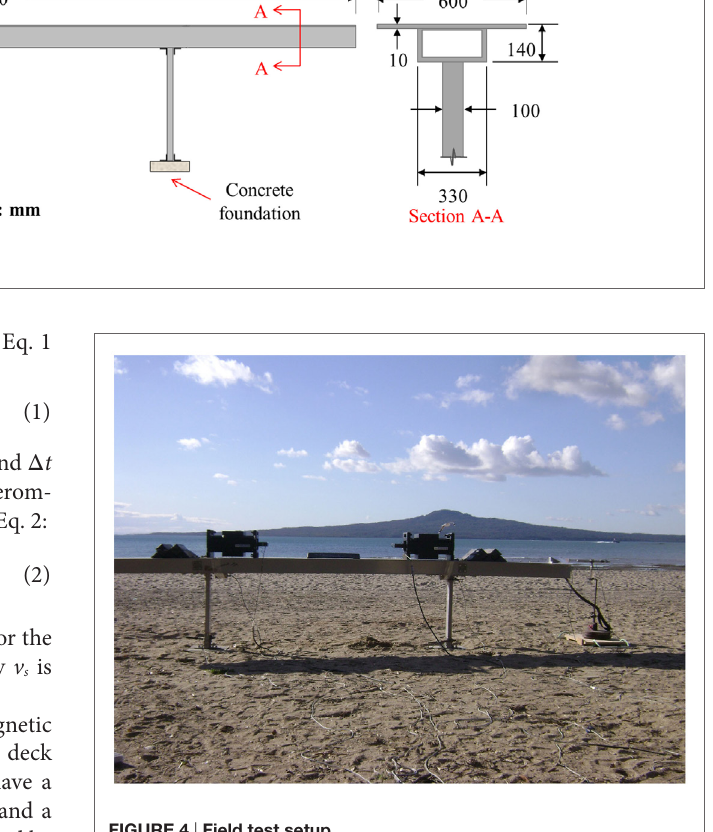
FigUre 4 | Field test setup .